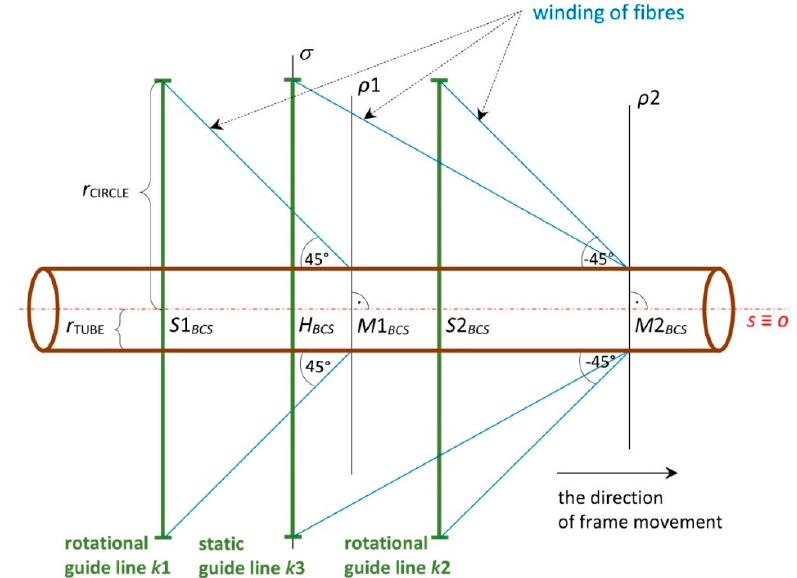
Figure 9. Schematic front view of winding fiber layers onto the non-bearing core frame, case when axis S BCS of the fiber-processing head and axis O BCS of the frame are identical in displayed section, axis S BCS is parallel to the coordinate axis y BCS .